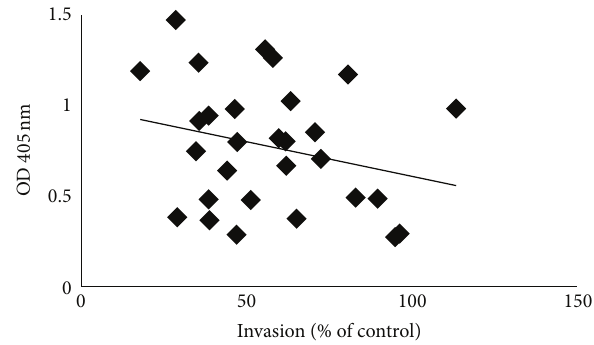
Figure 1: In a study of children with mild malaria in Uganda, IIA of a wild isolate was compared to ELISA using MSP2-3D7 as antigen 𝑅 2 = 0.07